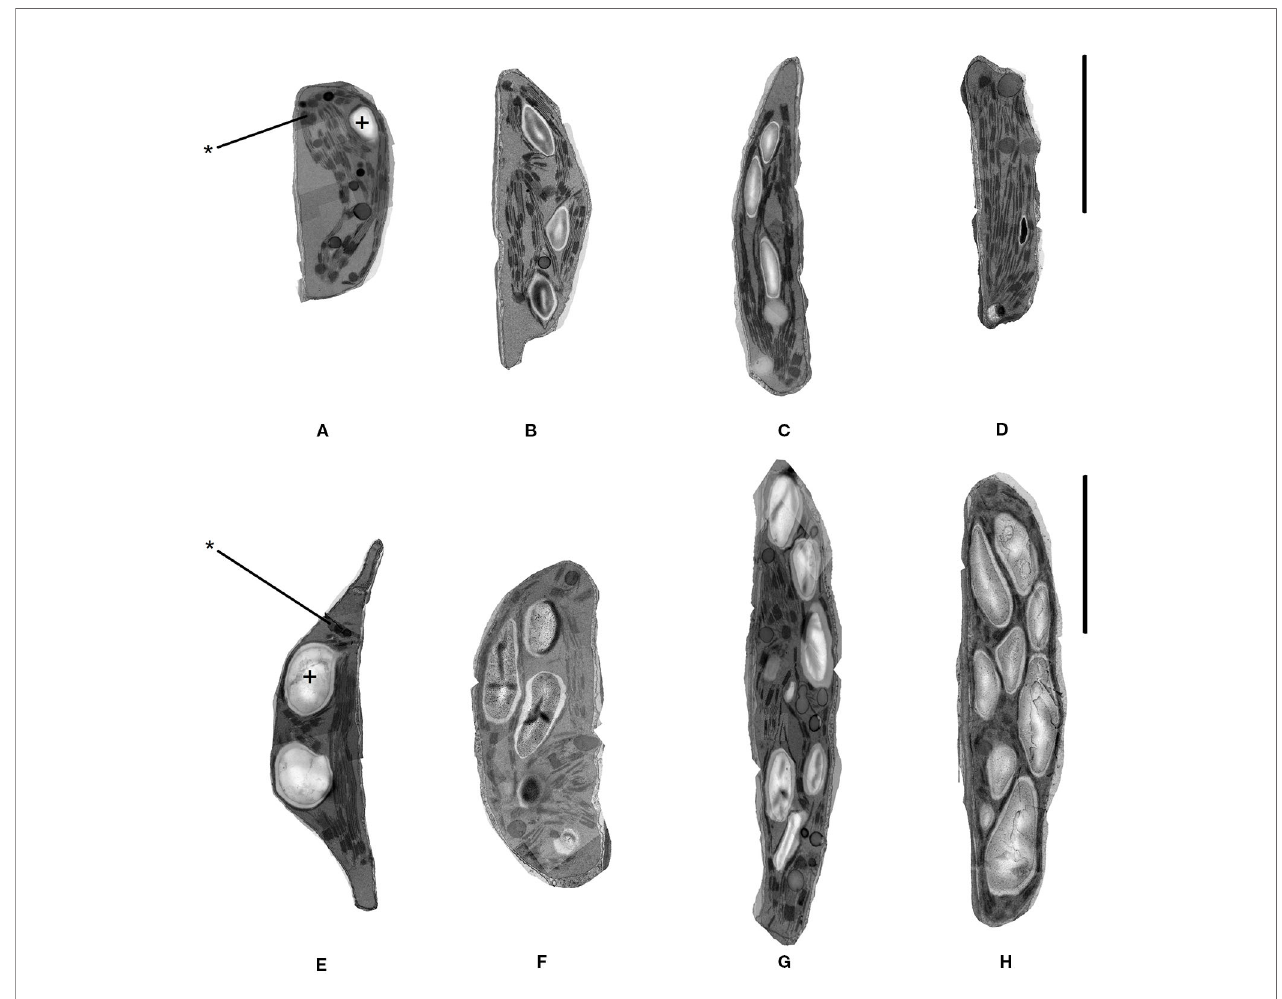
FIGURE 4 | Representative transmission electron microscope images of chloroplasts in upper-most fully expanded trifoliate leaves from DT97 (A – D) and PI-66 (E – H) . Images were acquired from samples collected on the 1 st day of 28°C treatment (A, E) , 7 th day of 28°C treatment (B, F) , 1 st day of 45°C treatment (C, G) , and 7 th day of 45°C treatment (D, H) . Black bars represent 1.0 µm. Starch grains and grana are identi fi ed with + and *,